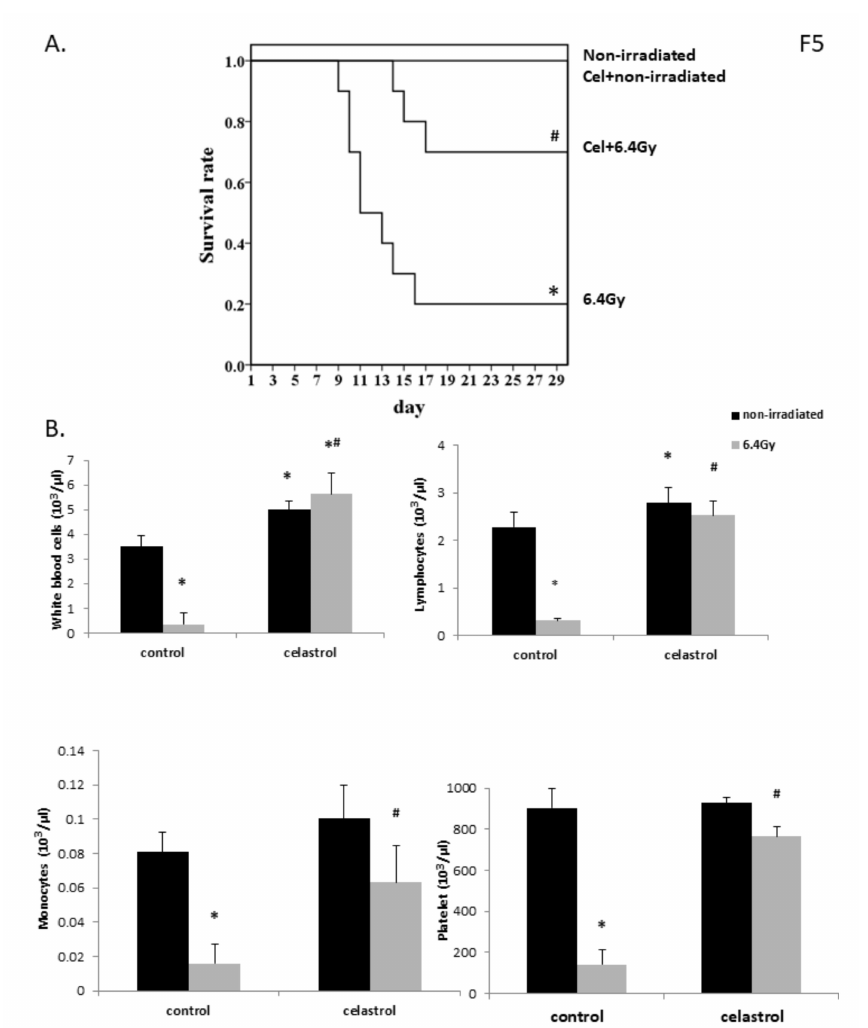
Figure 5. E ff ects of celastrol treatment on the survival rate ( A ) and hematopoietic level ( B ) in gamma irradiated mice. Four groups of mice were employed. Nonirradiated control and celastrol groups received either ip injection of 0.1% DMSO or celastrol at 0.25 mg / kg bw for 30 days without exposure to gamma irradiation. The irradiated mice were subjected to 6.4 Gy gamma irradiation at day 1, followed by ip injection of 0.1% DMSO or celastrol at 0.25 mg / kg bw for 30 days. ( A ) Kaplan–Meier curve of the e ff ects of celastrol on the survival rate of mice. ( B ) The numbers of white blood cells, lymphocytes, monocytes, and platelets. Data are expressed as mean ± S.E.M ( n = 3 for 6.4 Gy group and n = 5 for other groups). Comparisons between groups were analyzed by One-Way ANOVA followed by Tukey’s post-hoc test. * p < 0.05 vs. non-irradiated and no drug treatment group. # p < 0.05 vs. irradiated and no drug treatment group. 2.6. Celastrol Treatment Exerted Protective E ff ects in Mice Against Myelosuppression Induced by Gamma Irradiation Exposure to 6.4 Gy gamma irradiation promoted the development of myelosuppression: leucopenia, monocytopenia, lymphocytopenia, and thrombocytopenia in mice, demonstrated by the decreased numbers of white blood cells, monocytes, lymphocytes, and platelets in mouse blood (Figure 5B). The treatment with celastrol for 30 day in mice significantly improved the levels of hematopoietic cells. The nonirradiated celastrol group also showed increased levels of white blood cells and lymphocytes compared with the control mice. These observations demonstrated the function of celastrol in improving myelosuppression in mice at the hematopoietic